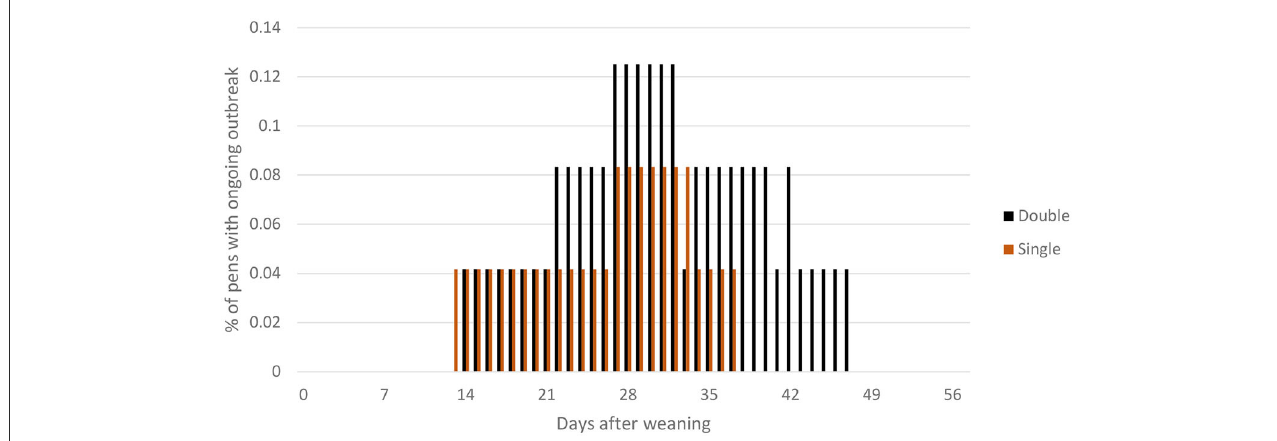
FIGURE3 Percentage of pens with ongoing tail-biting outbreaks (defined as being between the criteria for the start of an outbreak and successful resolution, criteria for each of these are explained in the text) plotted against days post-weaning within DOUBLE and SINGLE.